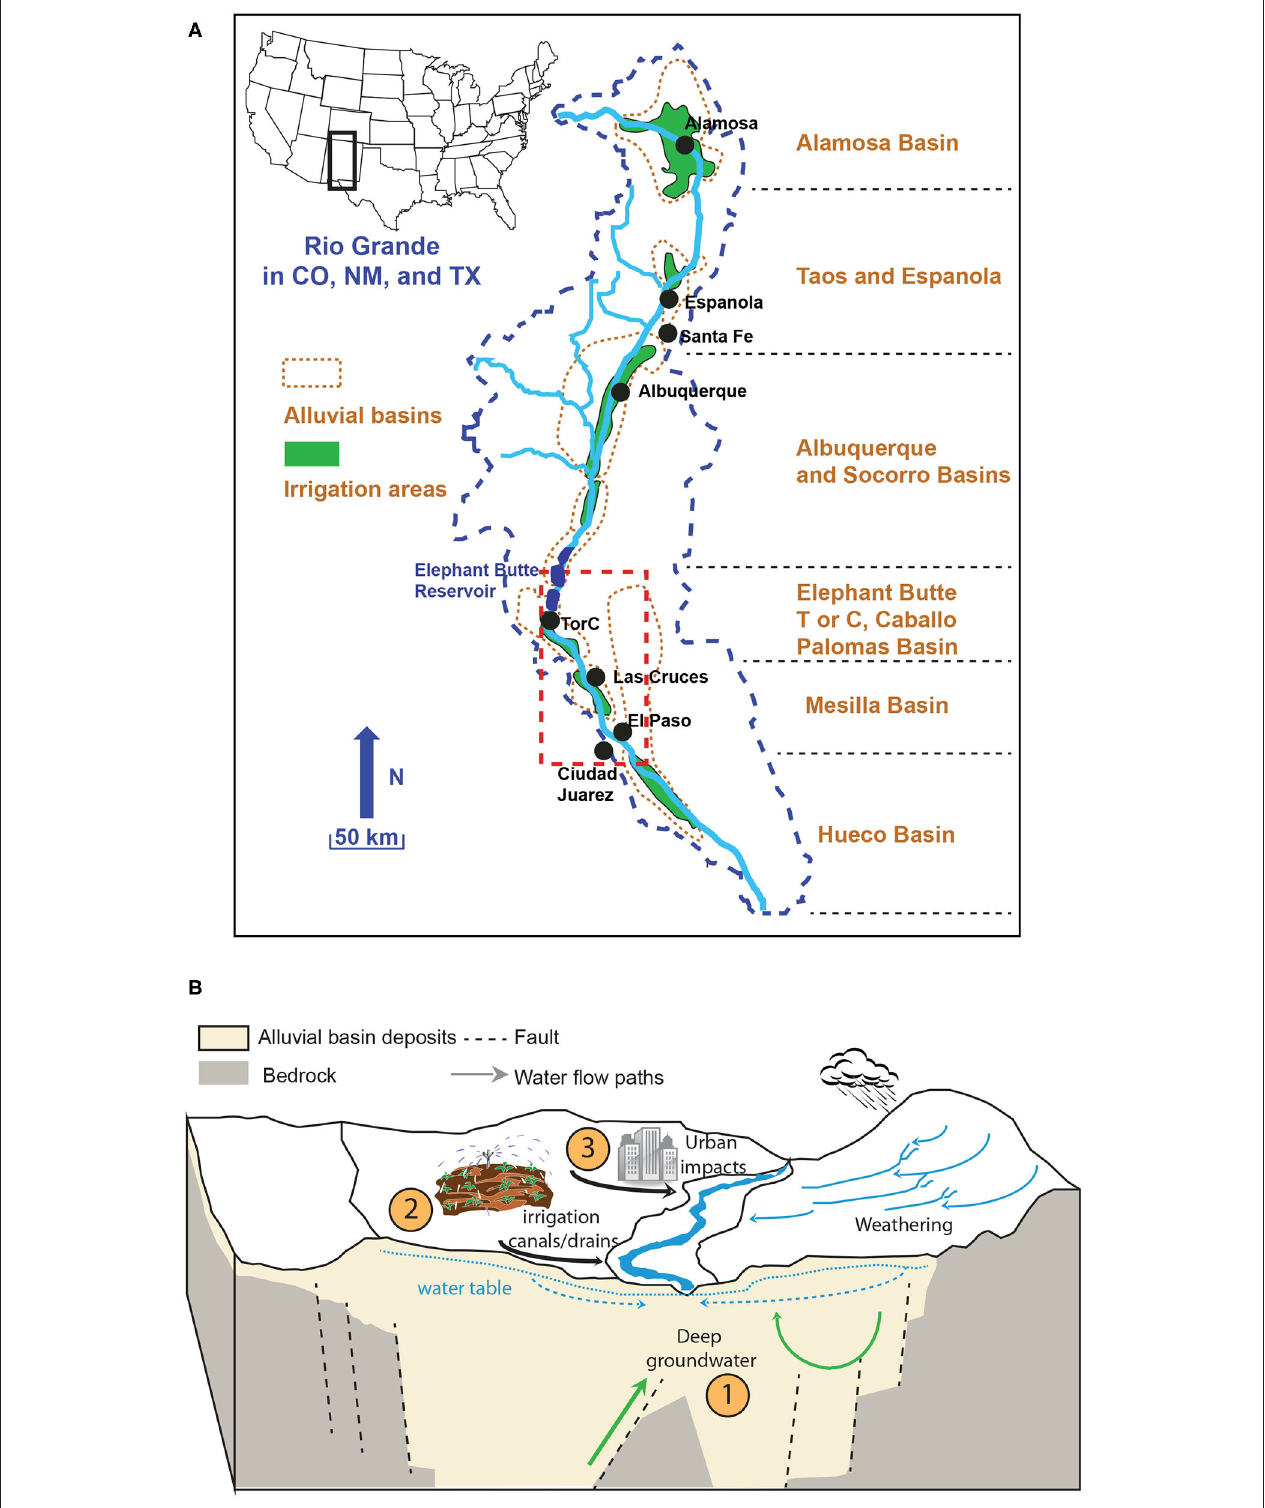
FIGURE 1 | (A) The Rio Grande Watershed in Colorado, New Mexico and Texas (after Phillips et al., 2003; Hogan et al., 2007; Szynkiewicz et al., 2011). Major alluvial basins, cities, and irrigation areas along the river are indicated. Red dashed box indicates the detailed study area shown in Figure 2 ; (B) A simplified block model of multiple salinity sources in the Rio Grande Watershed. Natural and anthropogenic processes (numbers highlighted in closed circles) are included: (1) upwelling of deep groundwater and geothermal water; (2) agriculture water; and (3) urban activities. Chemical weathering is also an important process to control solute and salinity input but plays a limited role in semi-arid and arid